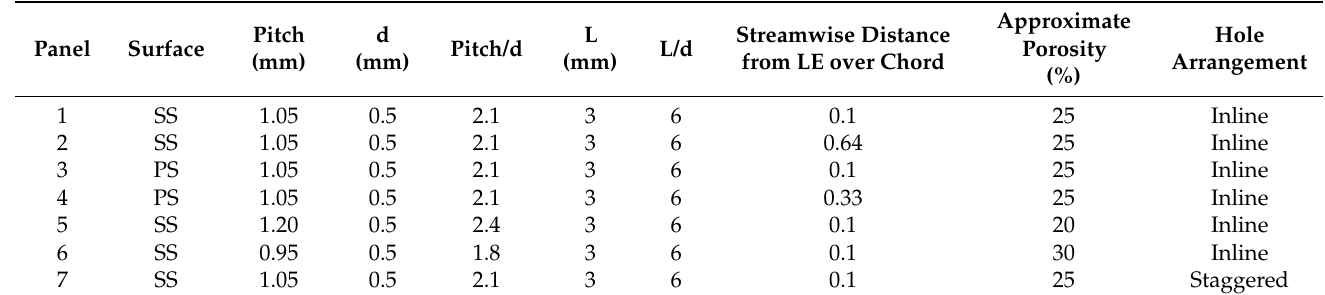
Table 1. Summary of geometries tested.